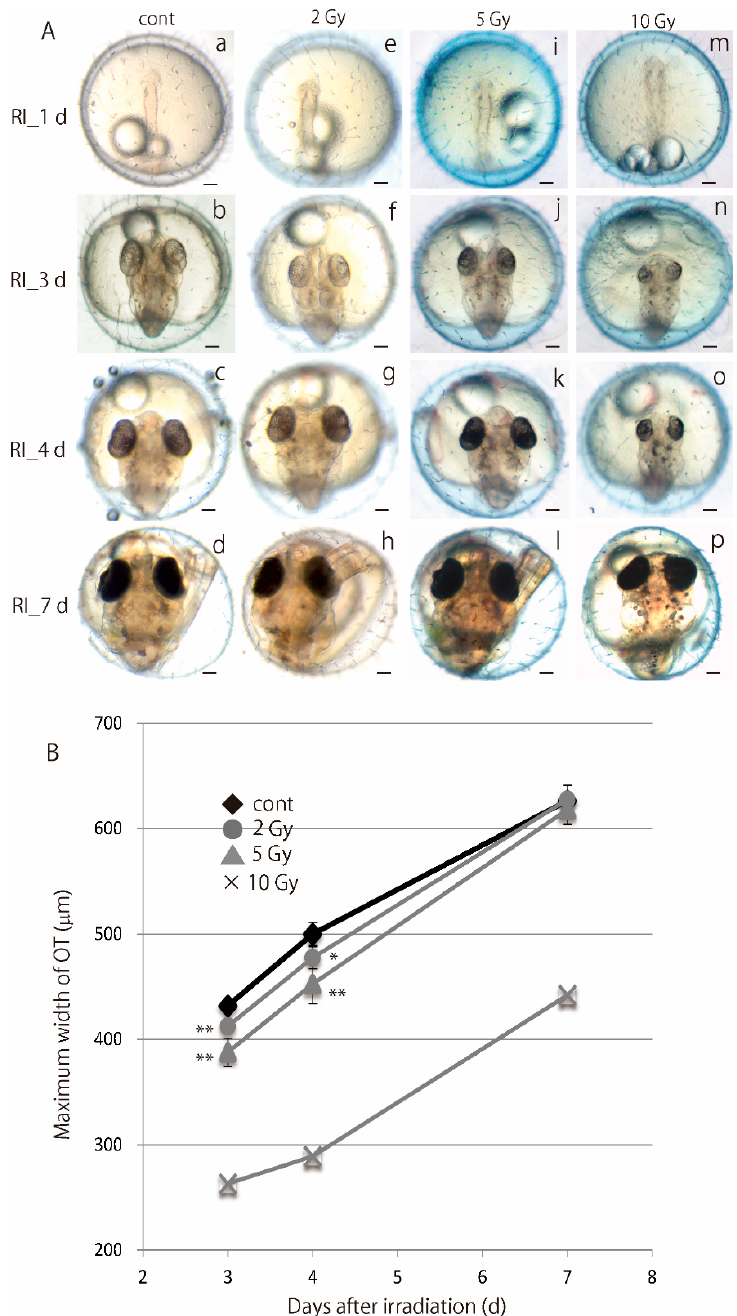
Figure 2. Transient delay of brain development before hatching in the irradiated blastula embryos with non-lethal dose of gamma-rays. Blastula embryos were irradiated with 2 or 5 Gy gamma-rays and hatched normally (h and l in A ), whereas those irradiated with 10 Gy gamma-rays died before hatching due to severe malformations ( n – p in A ). At 3 days and 4 days after the irradiation, brains of the blastula embryos irradiated with 2 Gy or 5 Gy gamma-rays were smaller (f and j in A ) than the controls (b in A ). After that, the brains of the irradiated embryos developed rapidly and their size became equal to those of the control embryos at 7 days after the irradiation. The temporal changes of the maximum width of the OT were shown in ( B ). Error bars show S.D. A p * < 0.05 was considered statistically significant and p ** < 0.01 was considered highly statistically significant. Scale bars = 100 μ m.